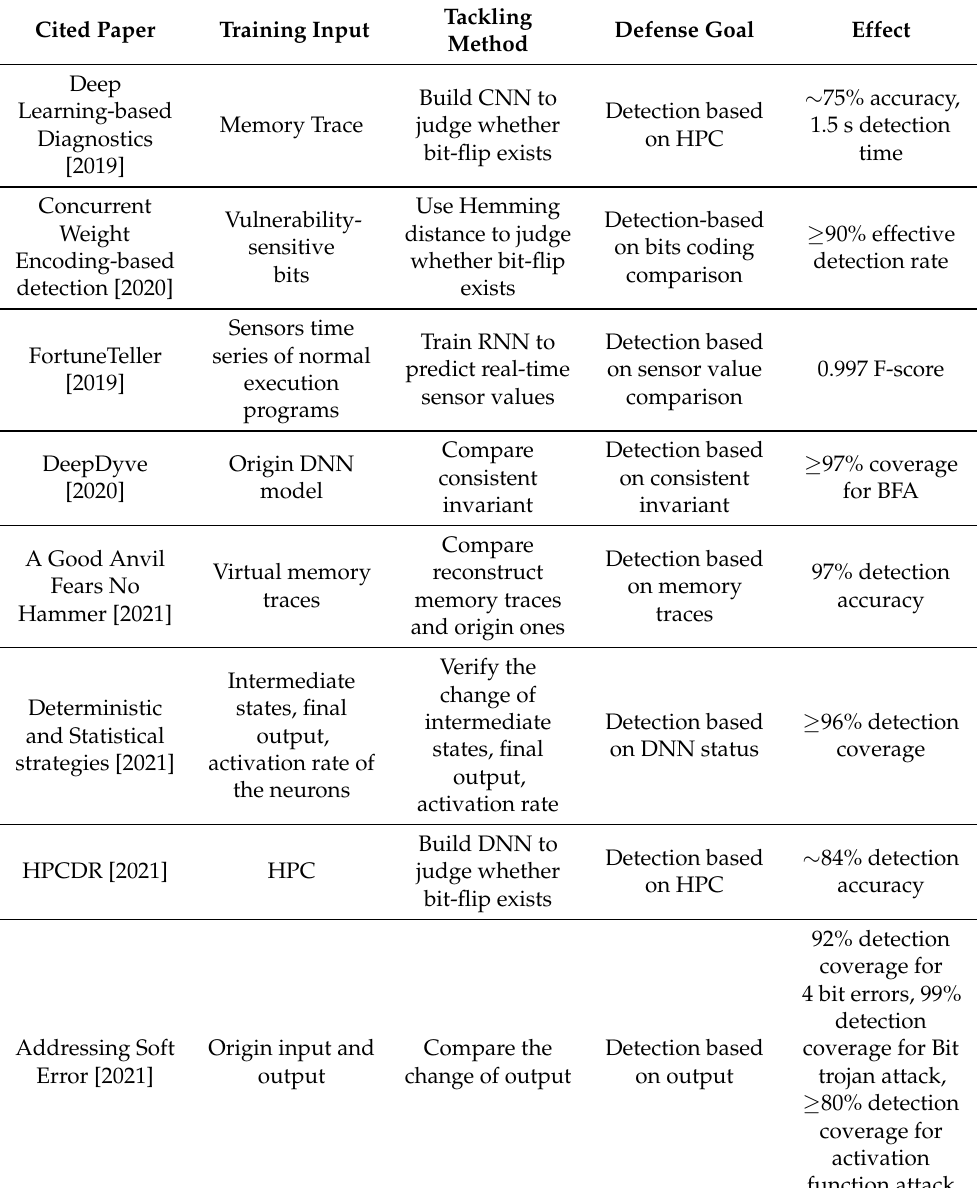
Table 11. Attributes of works that aims to use machine learning for detecting